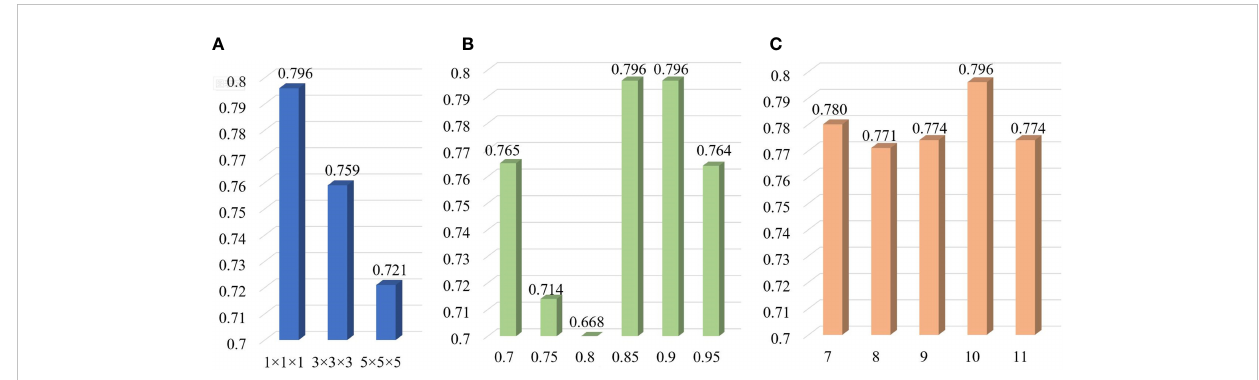
FIGURE 3 AUC values of LR models with various parameters including the voxel spacing of isotropic data (A) , the Pearson threshold (B) and the number of retained features (C) in the training